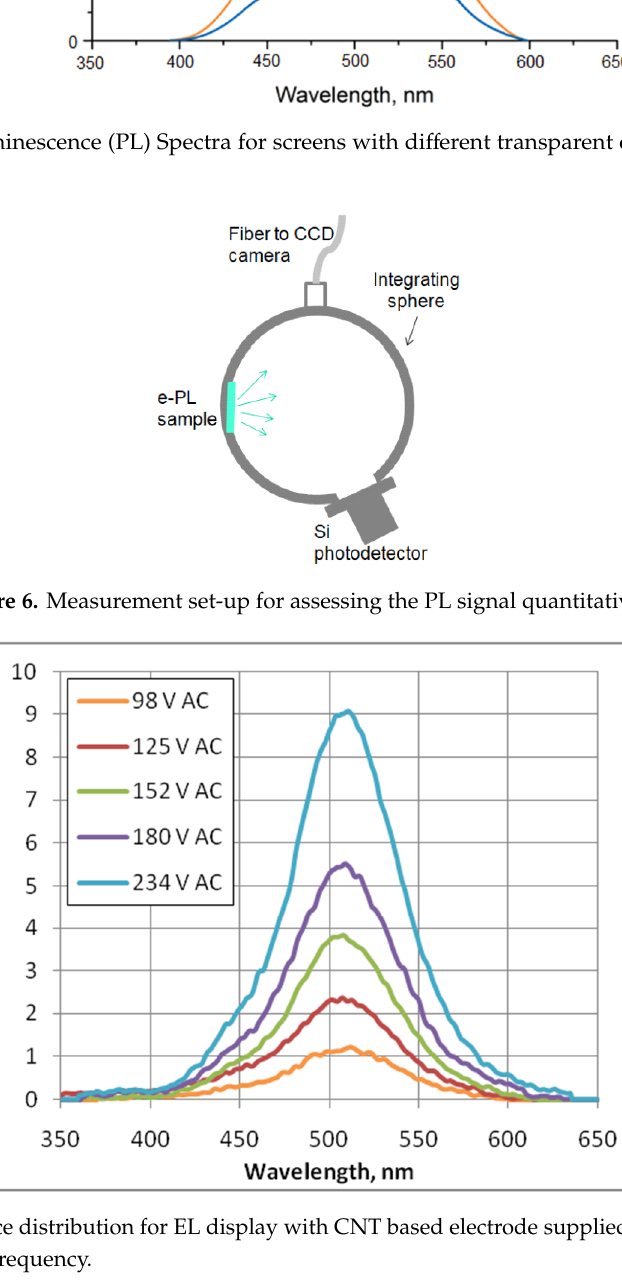
Figure 8. Luminance values for different AC voltages and different current frequencies.